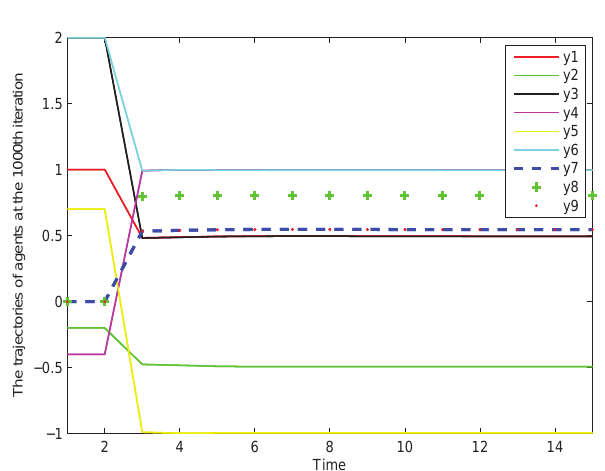
Figure 2. Signed graph.